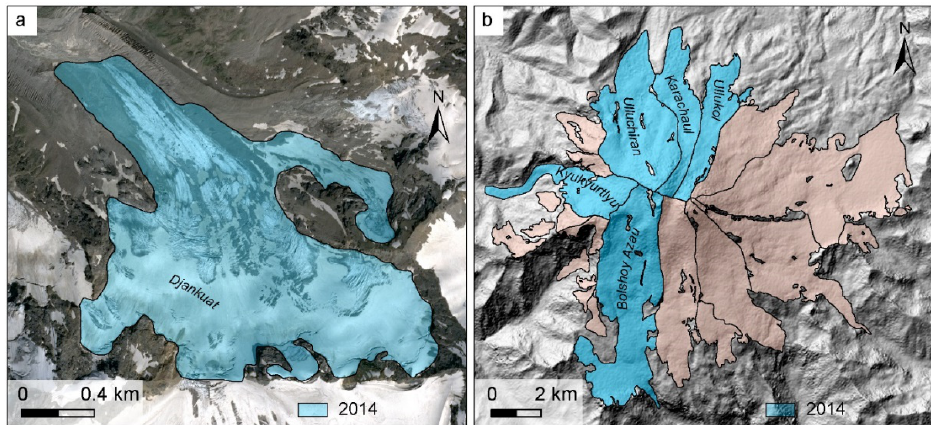
Figure 2. Location of Djankuat ( a ) and Elbrus ( b ) glaciers. Glaciers with blue colour from the Elbrus Massif were used for further comparison (see Chapter 4.2). SPOT image 2019 and ALOS PALSAR DEM was used as a background. See also Figure 1 for relative location of these glaciers to the Greater Caucasus.